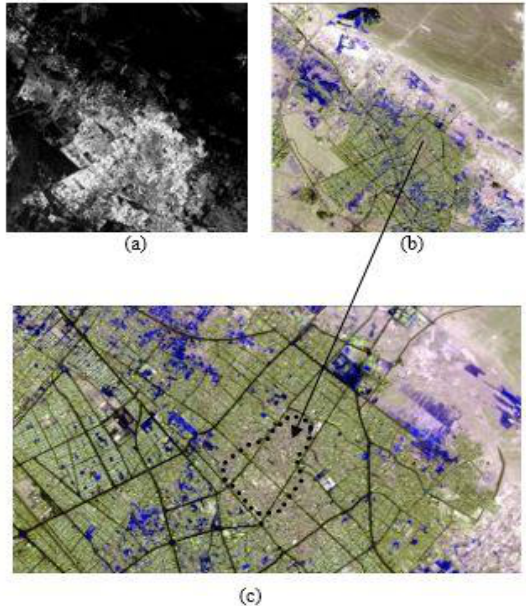
Figure 3. Band ratio of C/NIR band Red/Green (a, b, and c).